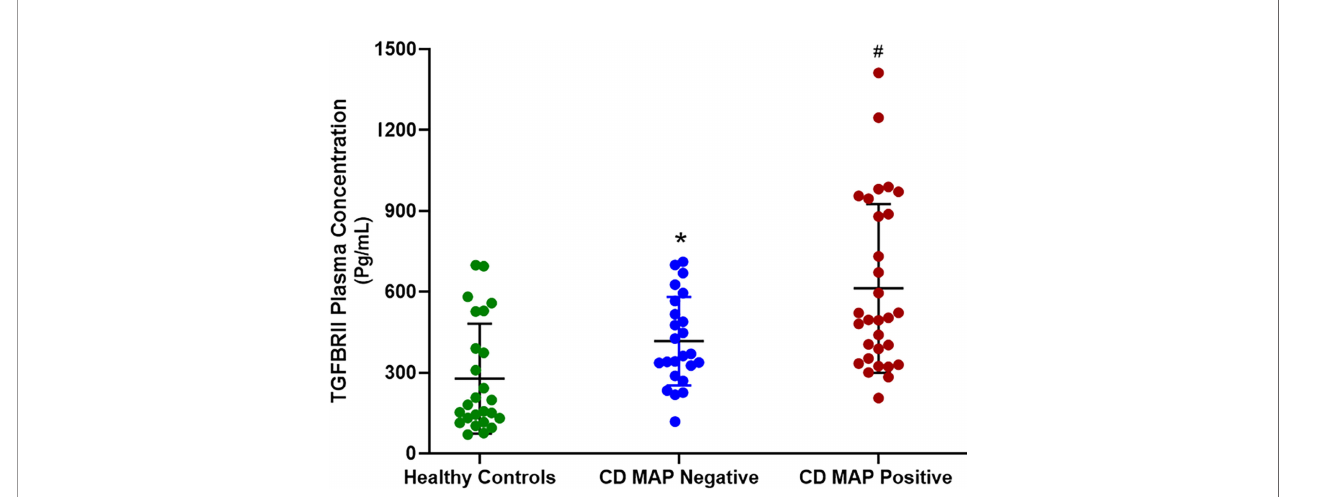
FIGURE 1 | TGF b RII shedding in clinical plasma samples obtained from healthy control subjects, MAP-negative CD patients, and MAP-positive CD patients ( N= 40 per group). The Kolmogorov – Smirnov normality test was used to test the normal distribution for all values and a two-way analysis of variance (ANOVA) was used to assess signi fi cance among experiments, which was followed by a Bonferroni correction test. All experiments were performed in triplicates. *P-value < 0.05 compared to healthy controls. # P-value < 0.05 compared to healthy controls and MAP-negative CD